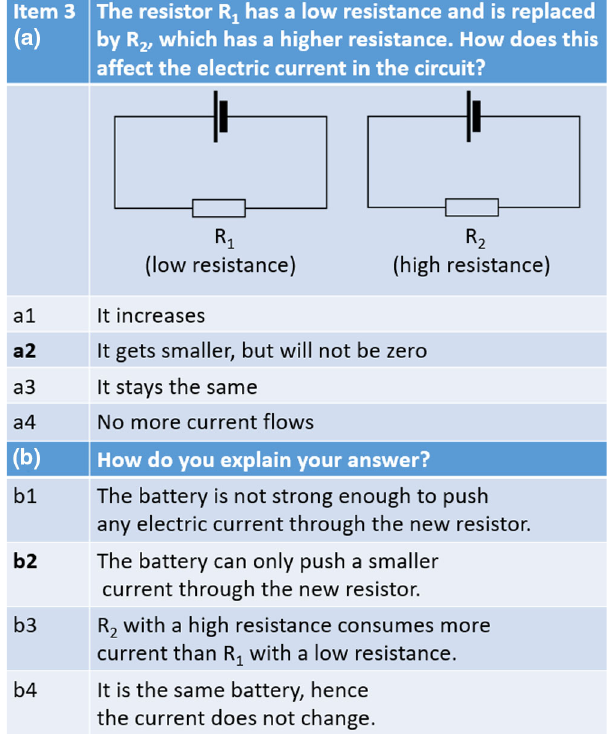
FIG. 15. A sample item from the test instrument illustrating the two-tier structure. The correct answer (a2) and explanation (b2) are printed in